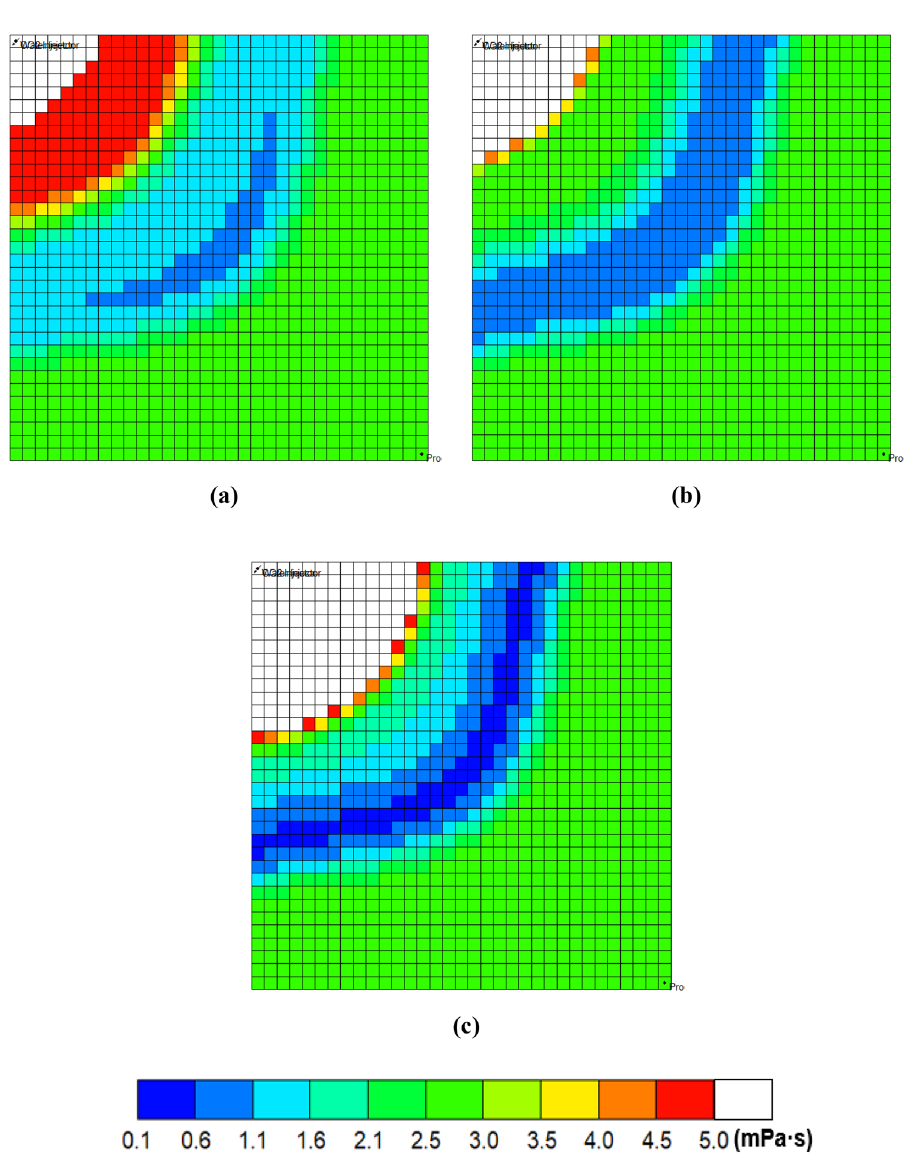
Figure 3. Oil viscosity with WAG: ( a ) 100% CO 2 , ( b ) 90% CO 2 + 10% LPG, and ( c ) 80% CO 2 + 20% LPG after the first cycle of gas